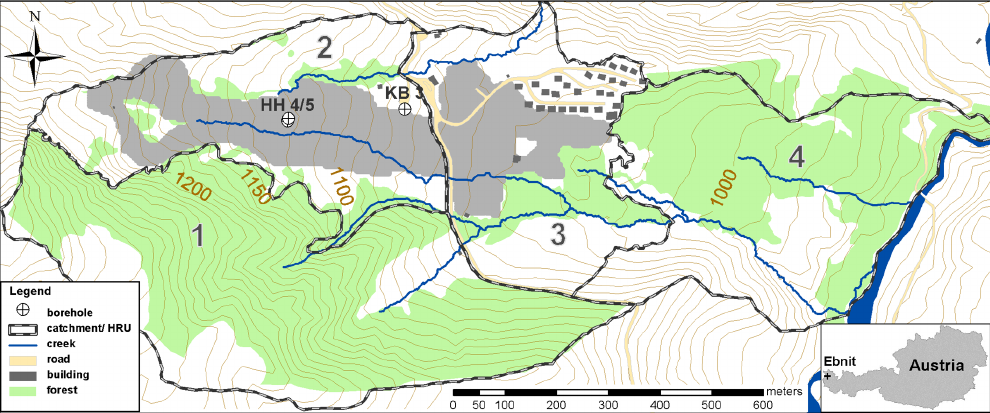
Fig. 1. Topography of the Heum¨oser catchment near Ebnit (Vorarlberg, Austria). The grey-shaded region indicate the open meadow area, on which geophysical mapping was focused. Numbers 1 to 4 denote the major hydrologic units (HRU). HH 4/5 and KB3 indicate the location of boreholes used for inclinometer measurements that specify the surface movement of the slope (see